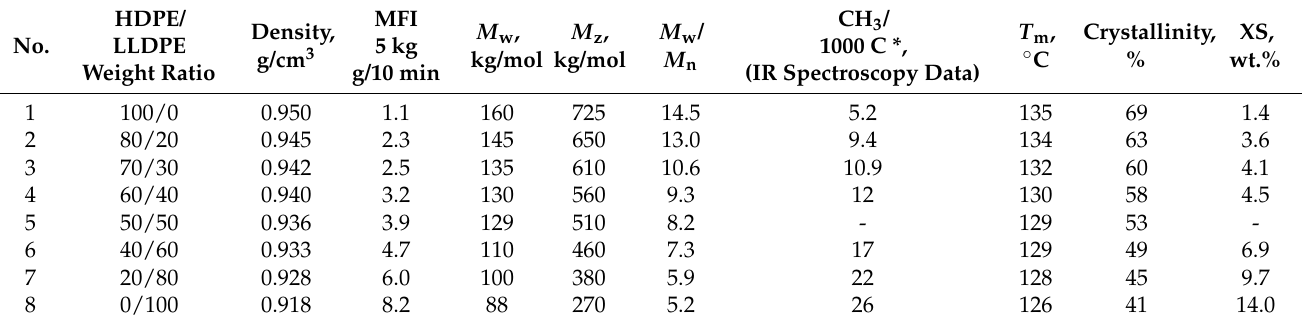
Table 6. The effect of the HDPE/LLDPE weight ratio on the MFI, molecular characteristics, and the content of CH 3 groups and o-xylene-soluble fractions of the compositions.